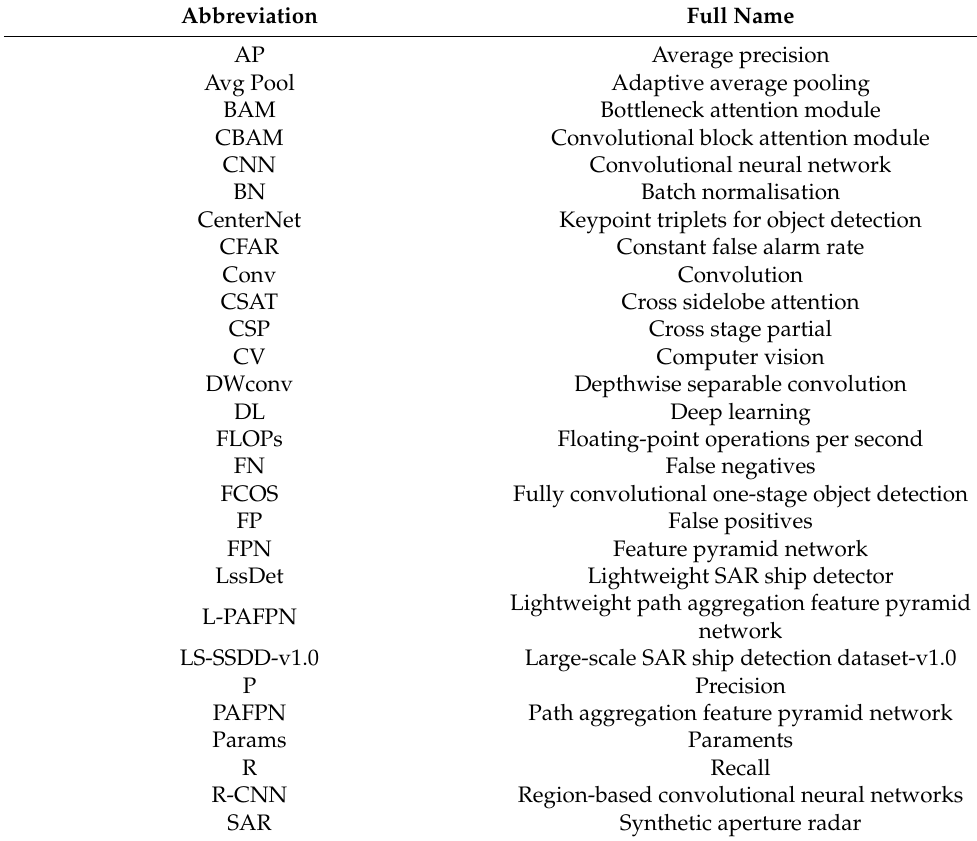
Table A1. The abbreviations and corresponding full